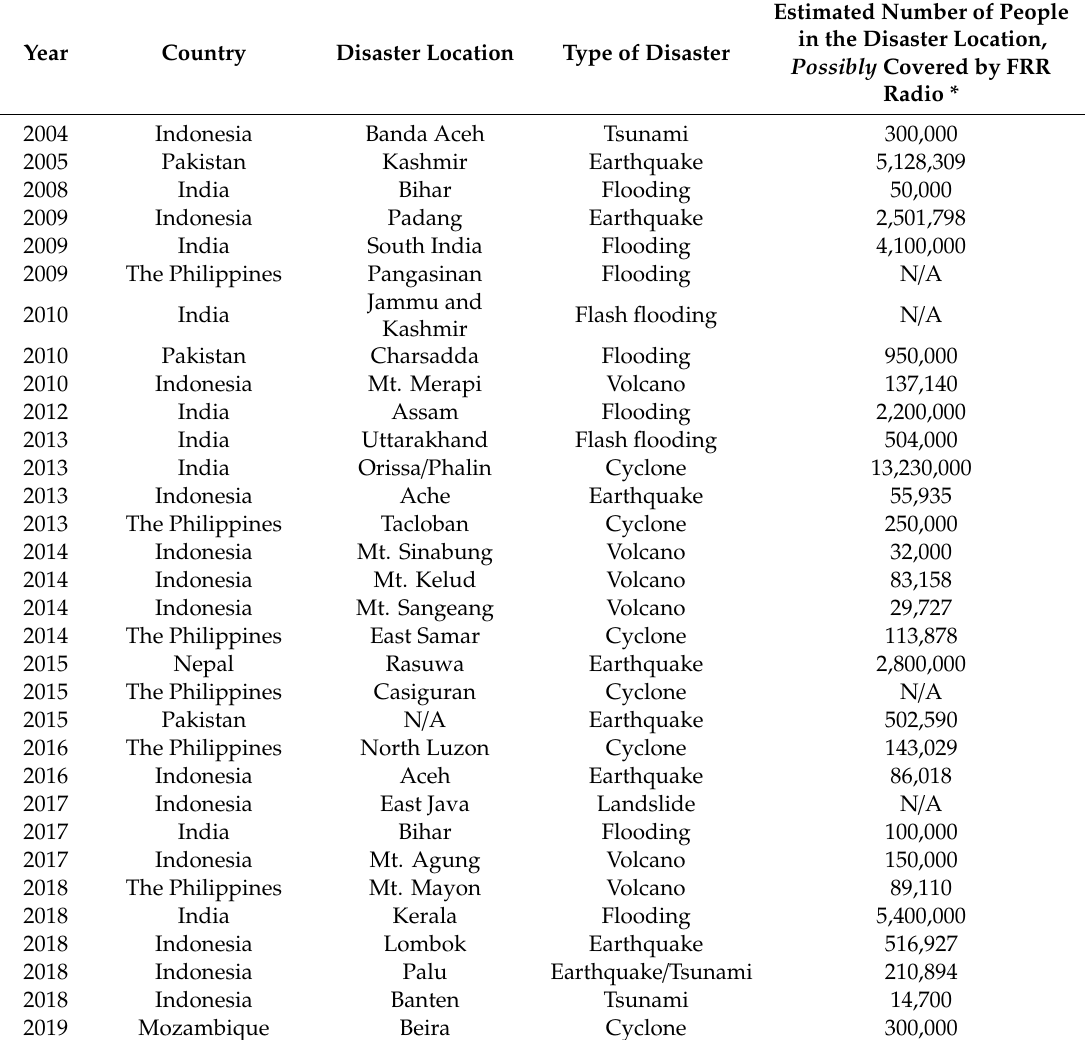
Table 3. Overview of First Response Radio (FRR) disaster response operations from January 2004 to April